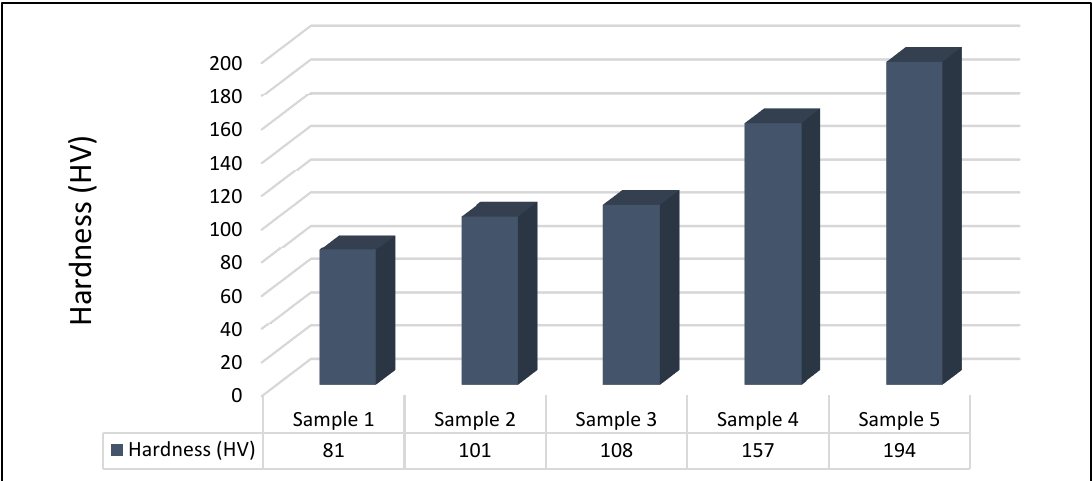
Figure 6. The variation of hardness for different samples .